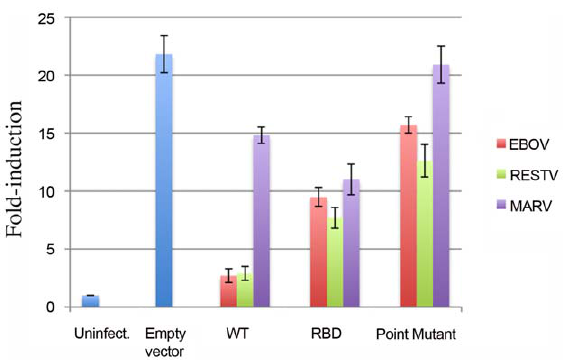
Figure 6. IFN antagonism by EBOV, MARV and RESTV VP35. HEK-293T cells were infected with Sendai virus and IFN b promoter activity was determined by firefly luciferase expression driven by the human IFN b promoter sequence in the presence of various versions of VP35. Uninfected cells and infected cells transfected with an empty vector were used as controls (blue bars). The inability of the RBD to reconstitute full inhibition of IFN signaling is the reason we call this region comprising residues 205–329 (and equivalent in EBOV) the RNA- binding domain (RBD) rather than the IFN inhibitory domain. doi:10.1371/journal.ppat.1002916.g006 Figure 7. Coating and end-capping of filovirus VP35 RBDs. The central basic patches of the different viruses. Dot-blot binding analysis reveals that MARV R301, K298 and R271 are critical to binding dsRNA. By contrast, K298 in RESTV and its equivalent K309 in EBOV, are not critical for dsRNA binding [10]. In MARV, the residues K311, K328 and I329 are not critical for dsRNA binding (Table 5). By contrast in EBOV, residues R322 and K339 are critical for dsRNA binding [10].